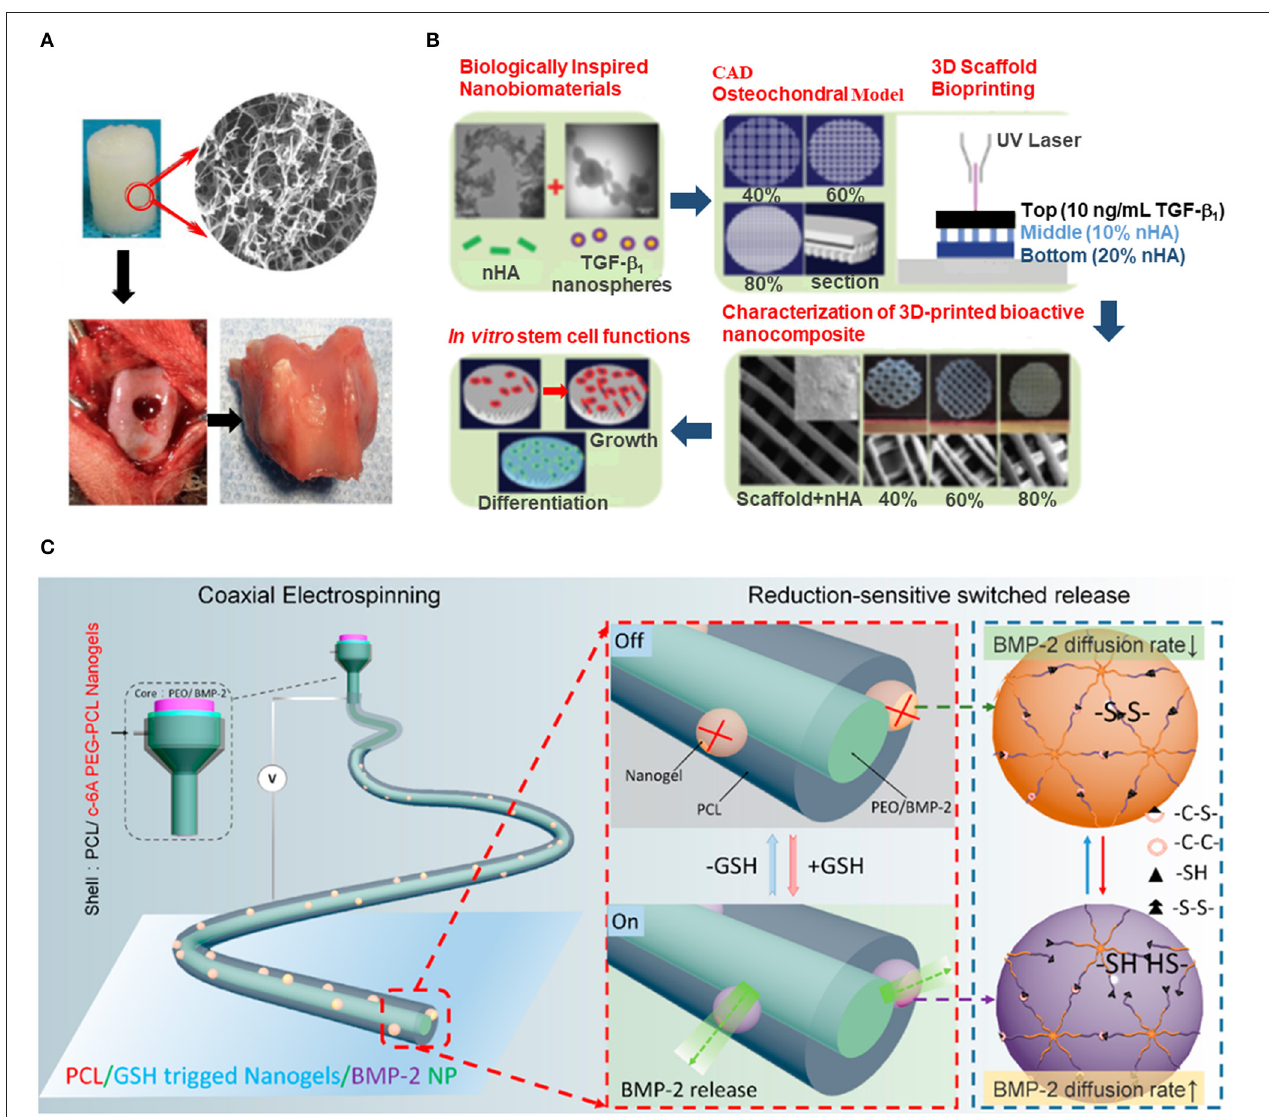
FIGURE 2 | 3D engineered nanomaterials for musculoskeletal tissue regeneration. (A) 3D scaffolds based on electrospun nanofibers of gelatin/PLA crosslinked with HA for osteochondral regeneration in rabbit model (adapted with permission from Chen et al., 2016, copyright, American Chemical Society). (B) Table-top SLA method to obtain porous hydrogel-based scaffolds that emulate the transitional nature of the osteochondral region by the inclusion of a gradient of nHA (adapted from Castro et al., 2015, with permission from The Royal Society of Chemistry). (C) Redox-responsive nanofibers allow the controlled BMP-2 release for bone regeneration in rat model (reprinted with permission from Gong et al., 2018, copyright American Chemical